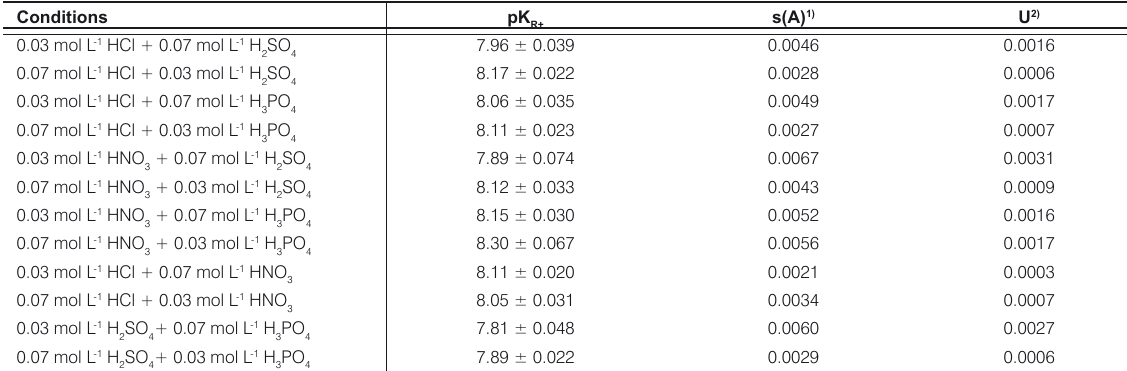
values of sanguinarine in the presence of TRIS R+